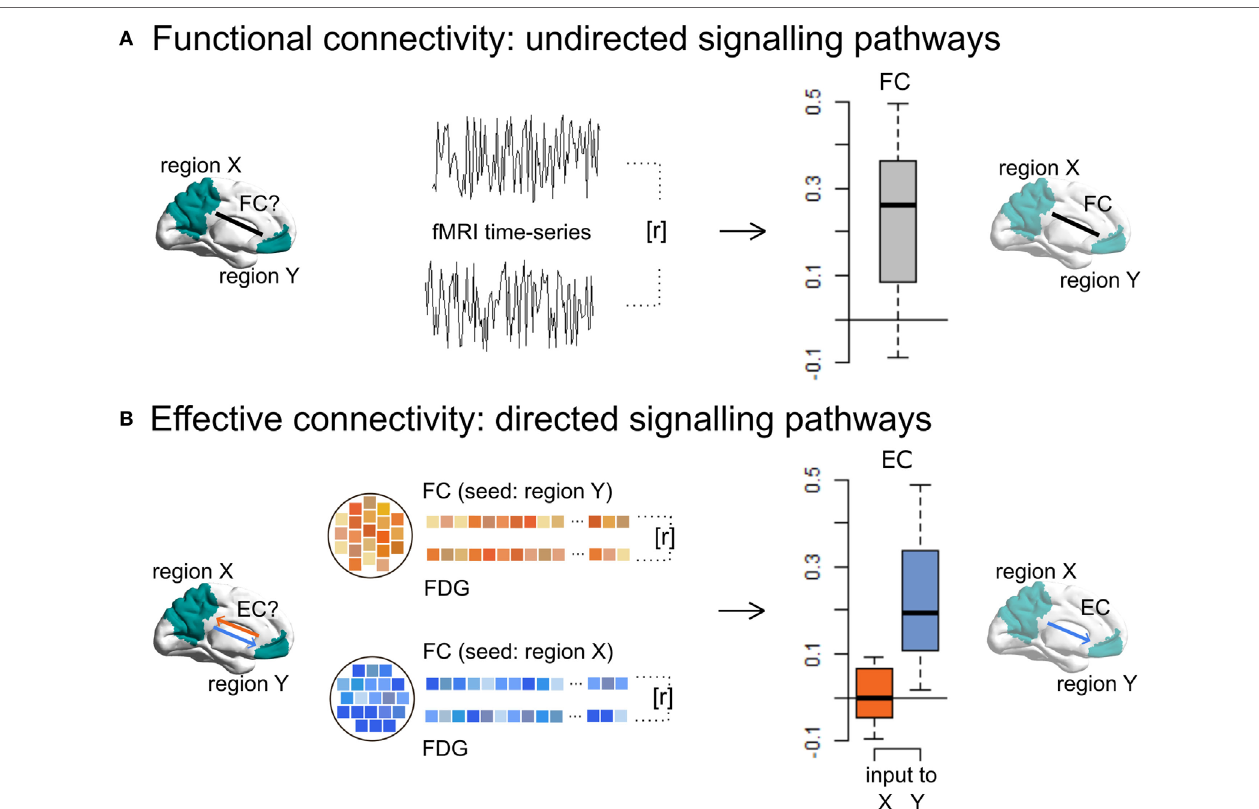
FigUre 2 | Metabolic connectivity mapping identifies intrinsic effective connectivity (EC), a proxy for directionality of signaling, in the human brain. (A) By using resting-state fMRI only, functional connectivity (FC), i.e., temporal correlations ( r ) between the spontaneous blood-oxygen-level-dependent fluctuations of a cluster X and Y, reflects non-directional communication among macroscopic brain regions. (B) Simultaneously acquired fMRI and FDG-PET data allow for the estimation of EC, i.e., the voxel-wise correlations ( r ) of FC and energy consumption. Since cellular recordings (see text) showed that the majority of signaling-related energy is consumed postsynaptically, positive correlations in a given region indicate signaling input along a FC pathway. This novel method can detect disease-related changes in directed connectivity in Alzheimer’s disease patients and further allows one to test directed connectivity-based spread models suggested by animal research. This figure is modified from Riedl et al.